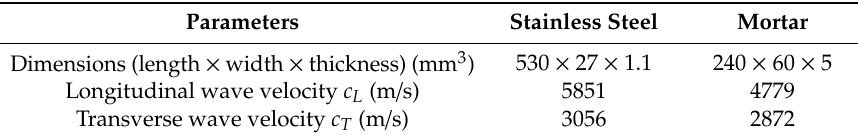
Table 1. Specimen